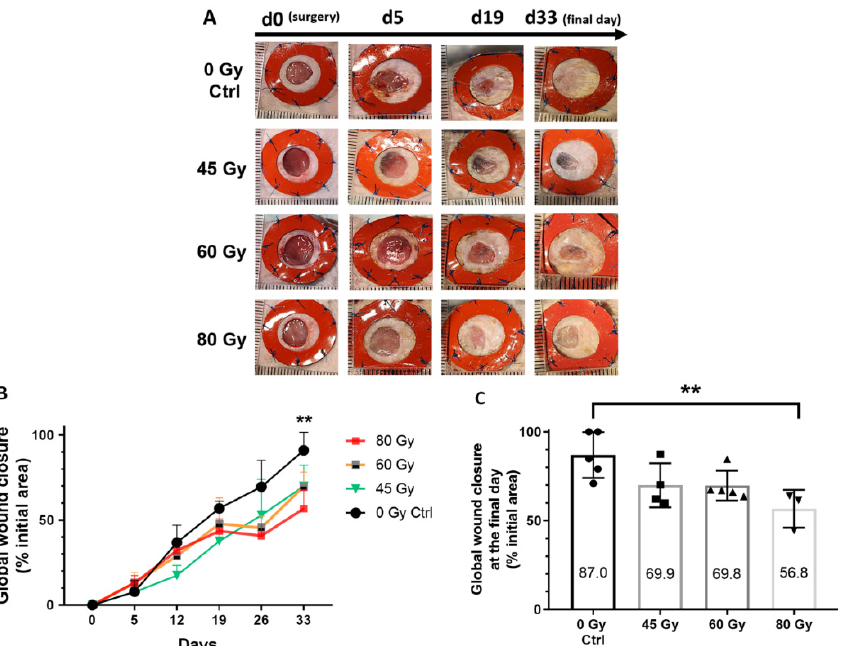
Figure 7. Healing kinetics of excisional wounds created on irradiated skin at the acute stage. ( A ) Macroscopic images showing the reduction in wound size over the course of 33 days after surgery. Measurements of global wound closure were made on such images for each wound, using ImageJ software. ( B ) Kinetics and ( C ) Global final wound closure values as a function of the dose received, reflecting the severity of the radiodermatitis that developed during four weeks prior to excisional surgery and splinting of the wounds. Statistics: mean ± SD. n = 3–5 mice/group, One-way ANOVA with Dunnett’s multiple comparisons test ** p < 0.01. * Symbol indicates significance between control and other groups.